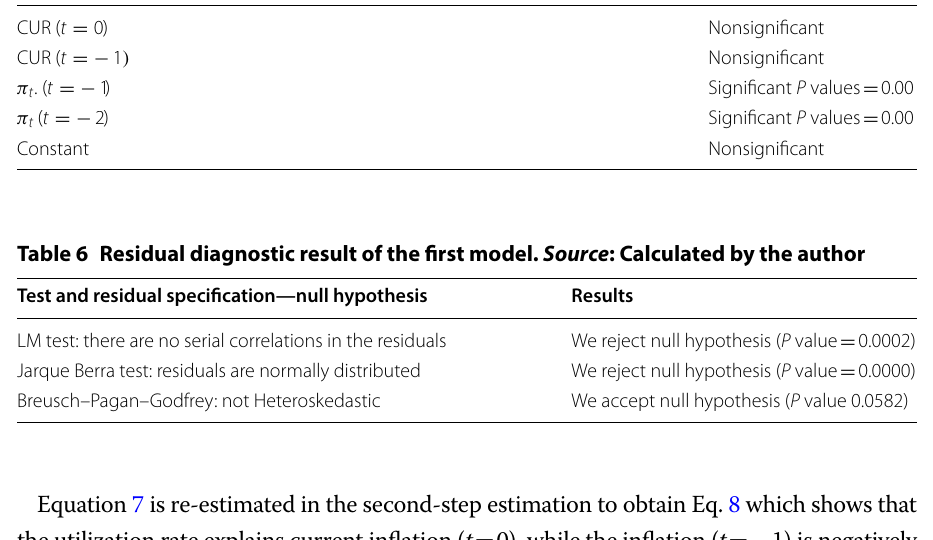
Table 5 First-step model 2 estimation. Source : Calculated by the author Variables Test results: significance